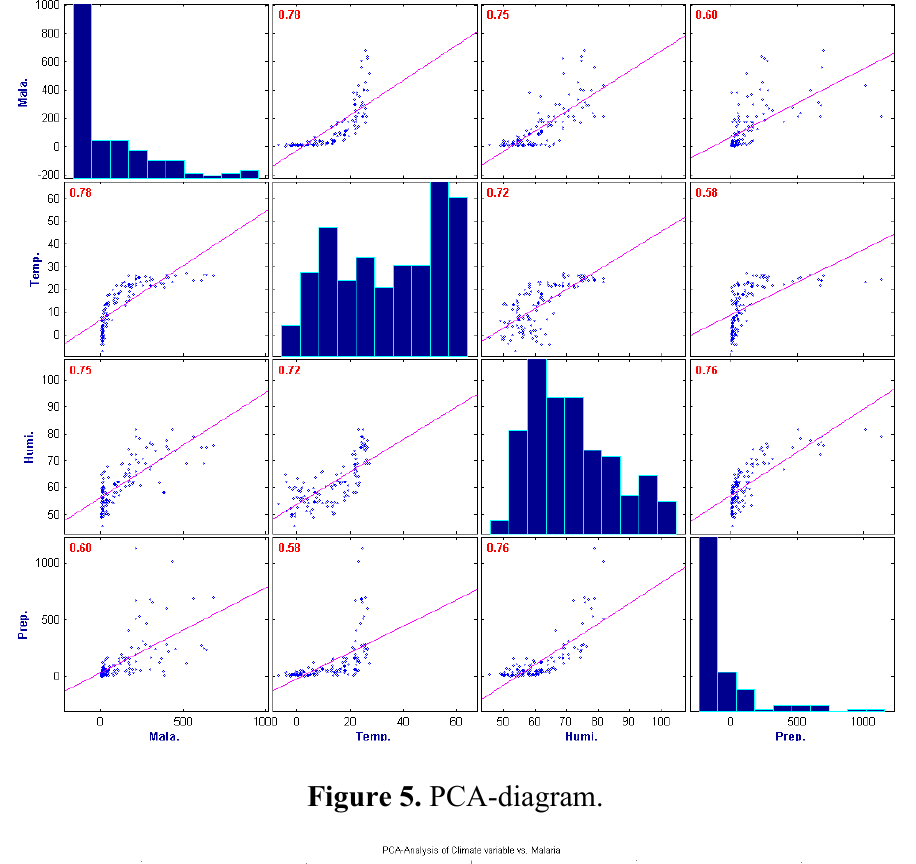
Figure 4. Correlation matrix of malaria and climate variable (Pearson’s correlation).